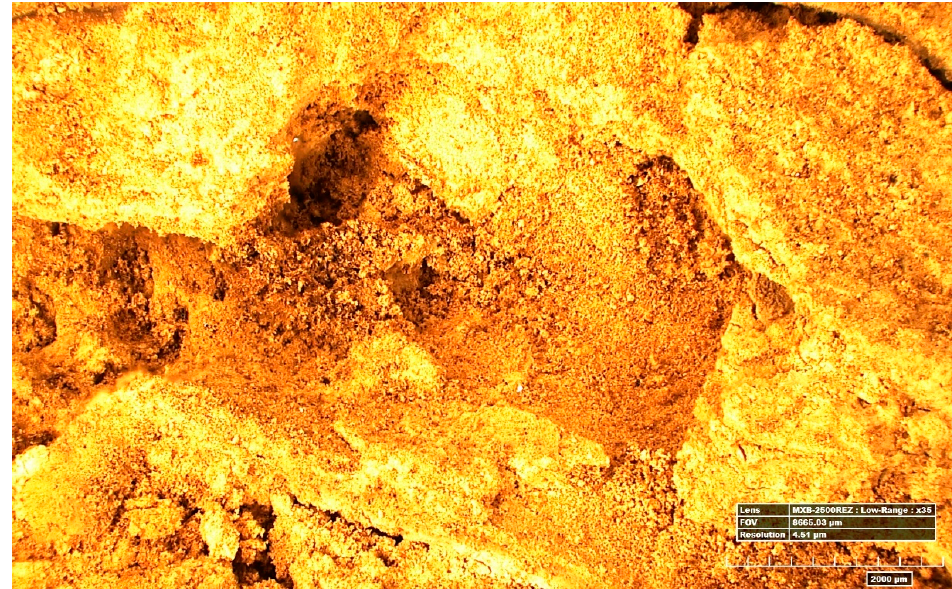
Figure 7. Image of sediment surface obtained in the HIROX RH-8700 digital microscope (magnification 35×).